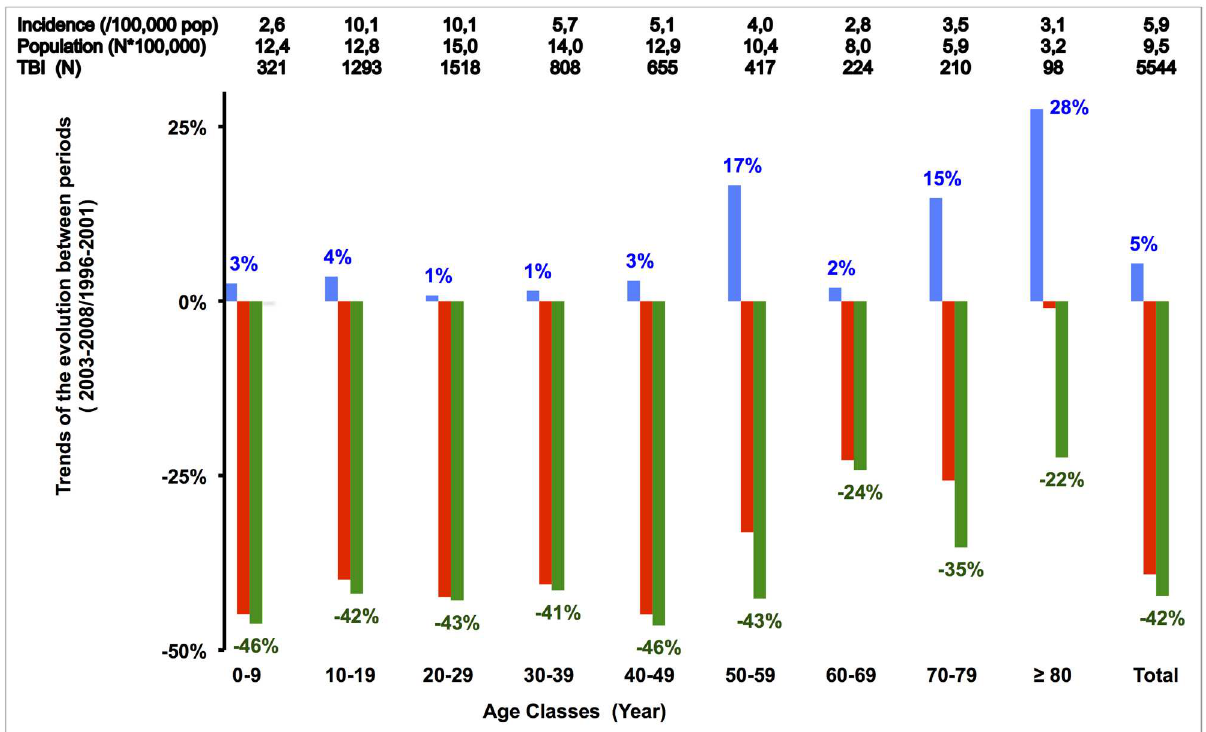
Fig 2. Trend of epidemic of RTC-related TBI incidence by age classes. Trends betweenthe earlier(1996–2001) and later (2003–2008) periods, for 1/ population(blue bars), 2/ number of RTC-related TBI (red bars) and 3/ RTC-relatedTBI incidence(green bars), dividedby 10-year age classes. For the period1996–2001,the exact numbers are also provided at the top of the graph. This Figure can be read as follows: for the period1996–2001,in the age class 0–9 years, populationwas 12.4 ( * 100,000)inhab., there were 321 TBI victims, and TBI incidencewas thus 2.6/100,000 inhab. When comparing with the later period, we observed a population increase of 3%, while the number of RTC-relatedTBI decreased 45%, and RTC-related TBI incidencedecreased